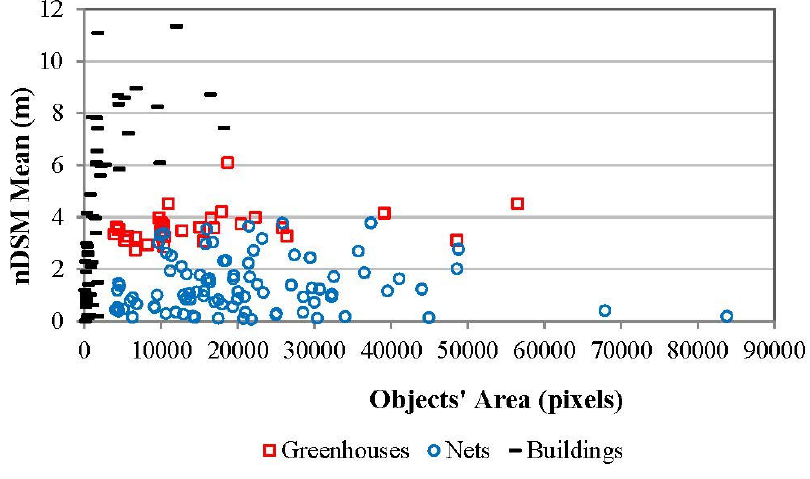
Figure 11. Mean height values of objects computed from GE1 stereo pair